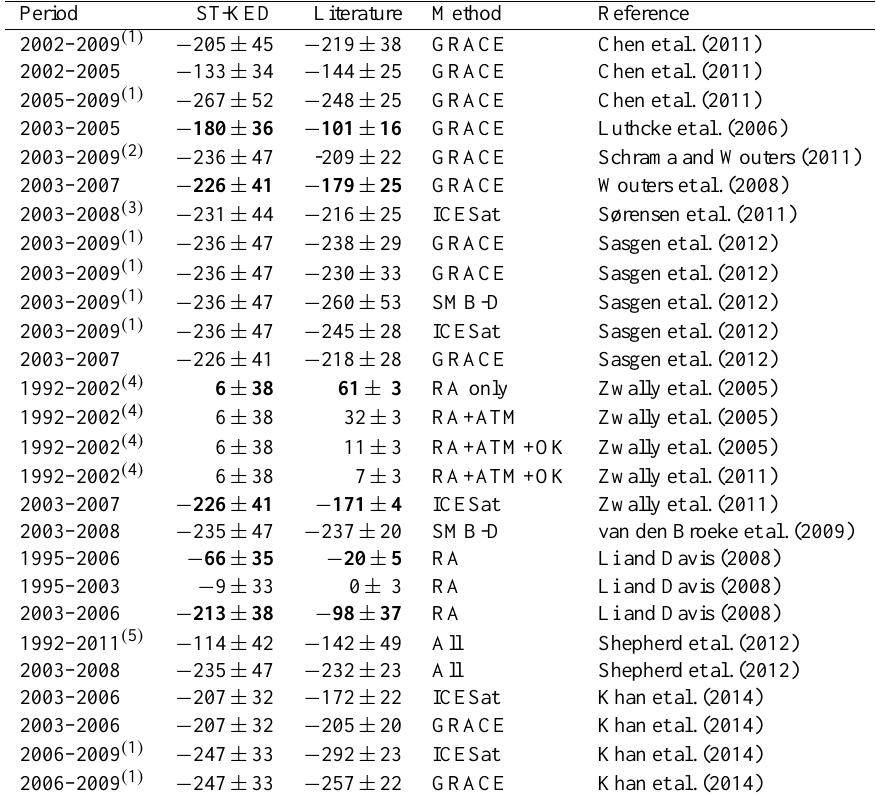
Table 3. Overview of mass change rate estimates in the literature compared to estimates resulting from this study. Estimates that are outside our estimated errors are printed in bold font. Periods were adjusted such that for every row both estimates consider the same period (see footnotes for details). Units are Gtyr − 1